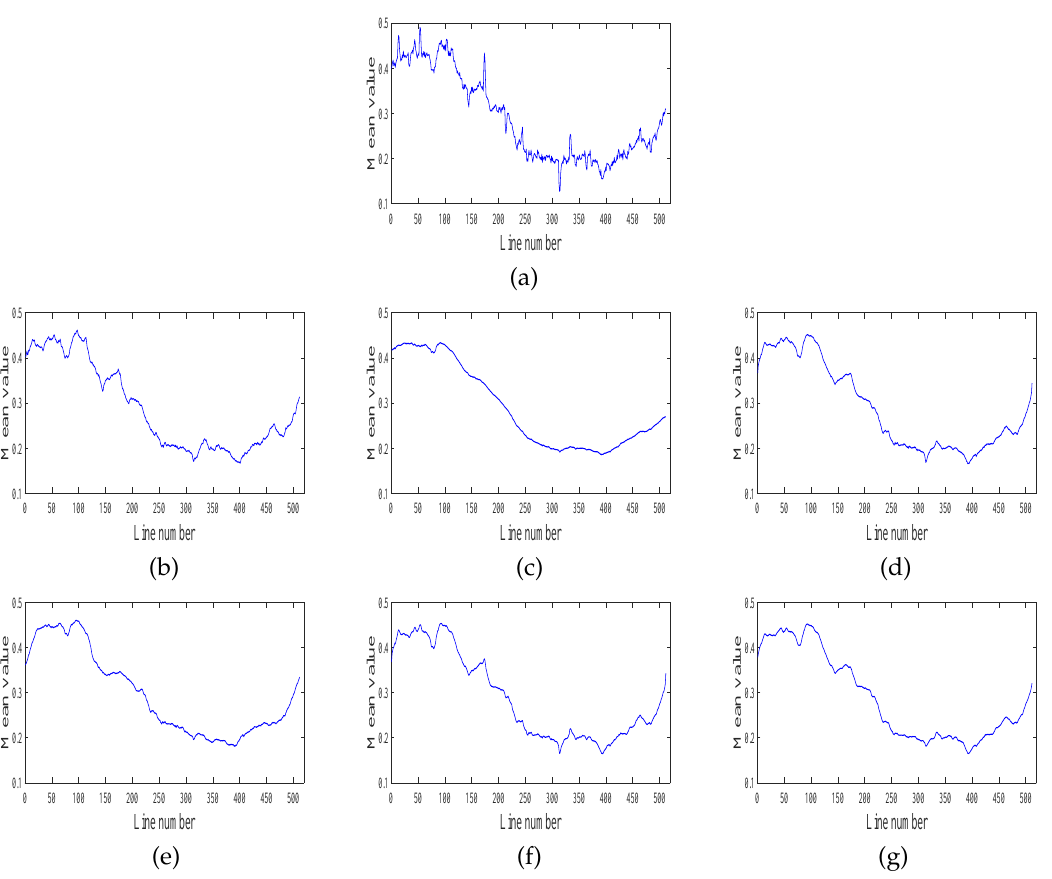
Figure 10. Spatial mean cross-track profiles for the first real example of Figure 7: ( a ) real image; and destriping results by: ( b ) WFAF; ( c ) SLD; ( d ) UTV; ( e ) GSLV; ( f ) LRSID; and ( g )